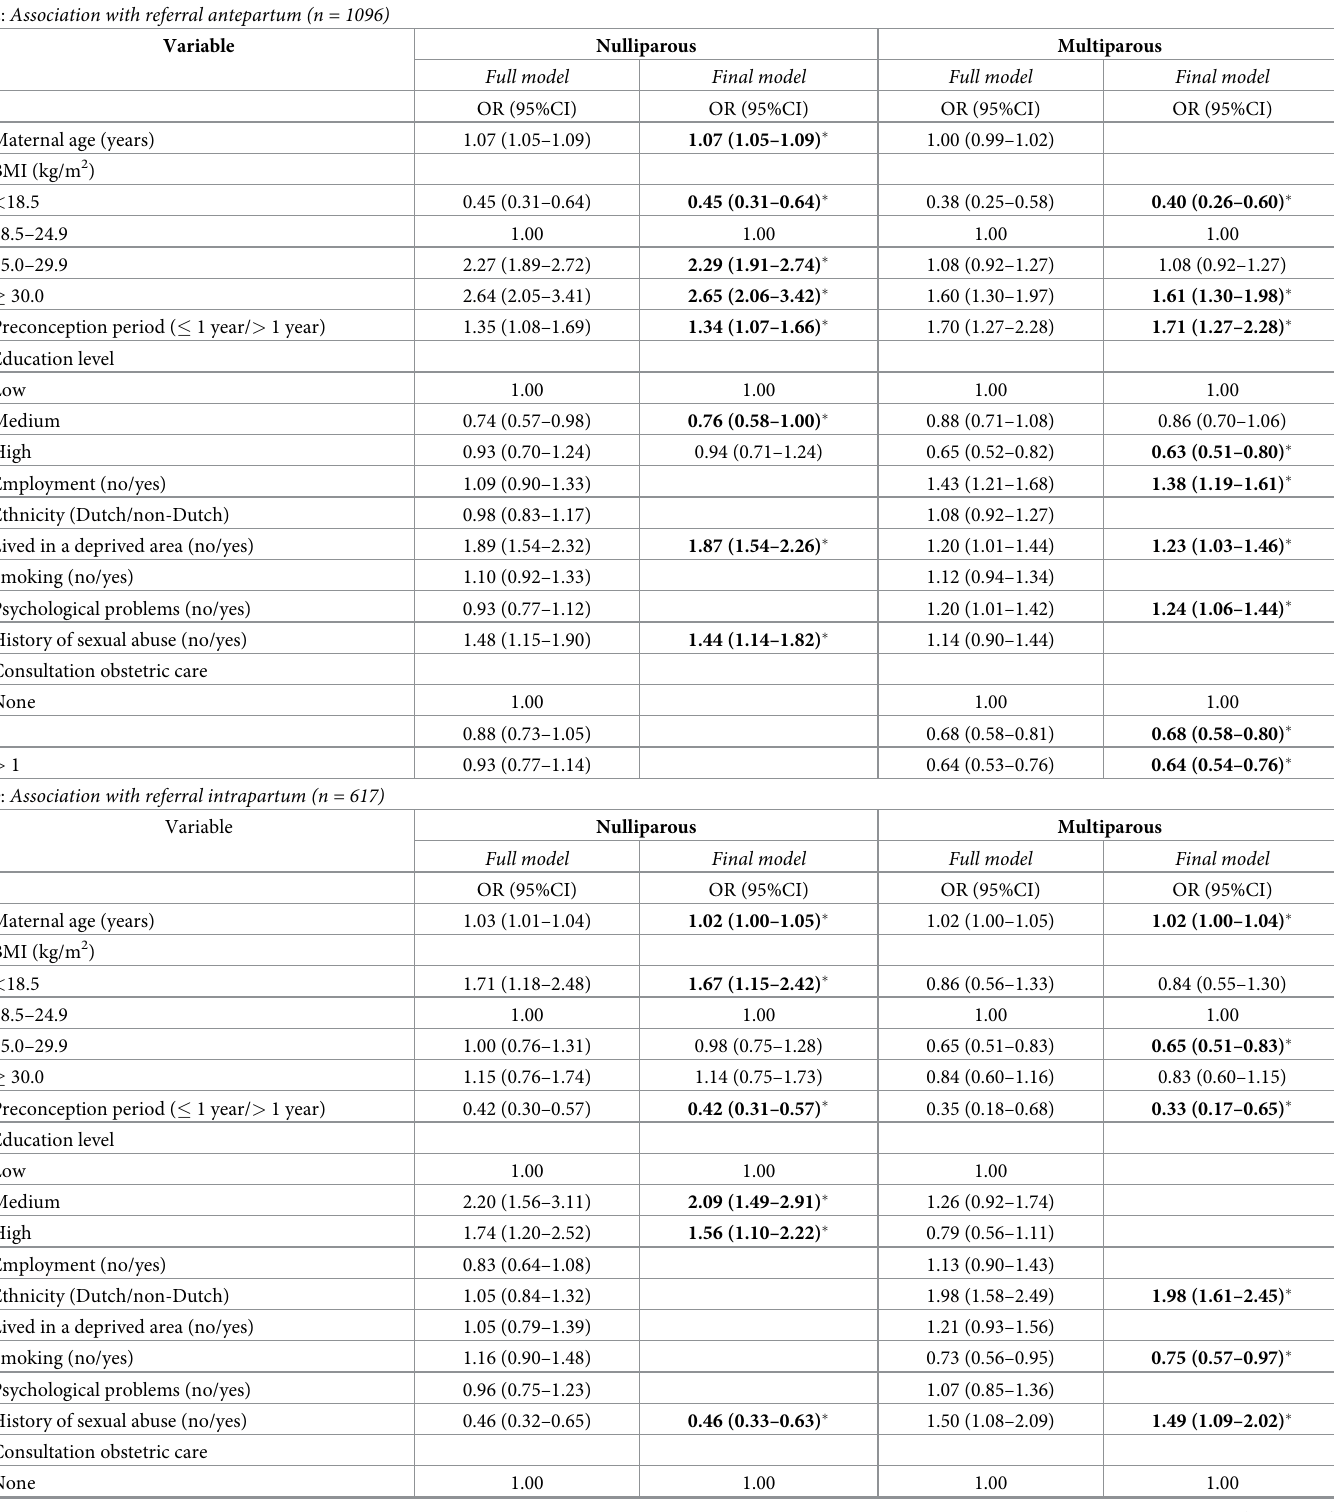
Table 2. Association with referral split by parity and